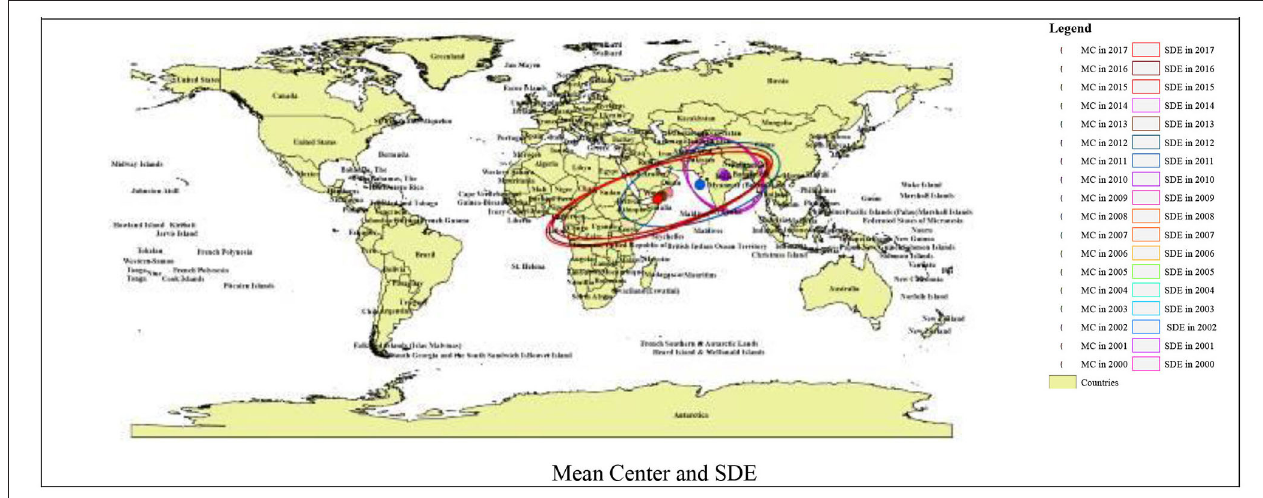
FIGURE 2 | Spatial clustering of diffused DRM, Getis Ord Gi* hotspot cluster analysis, Mean Center, and